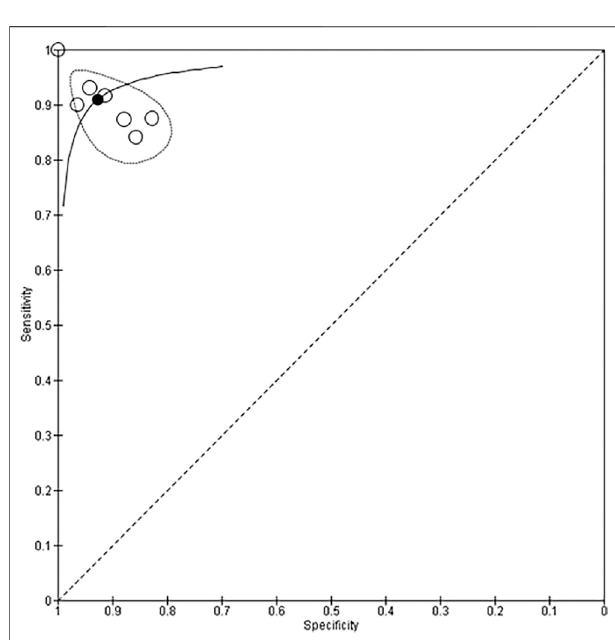
FIGURE 4| Summary receiver operating curve for use of neural network models to detect CHD.